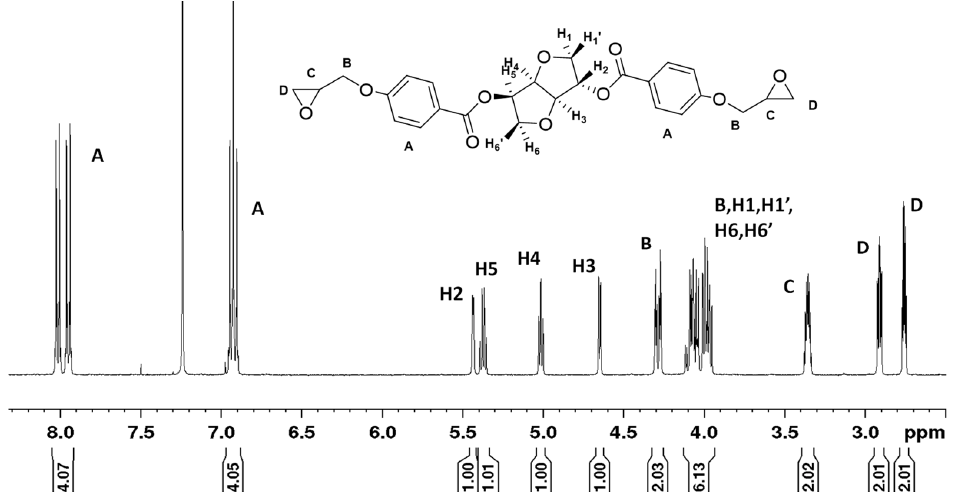
Figure 6. 1 H NMR Isosorbide 2,5-bis(4-glycidyloxybenzoate).